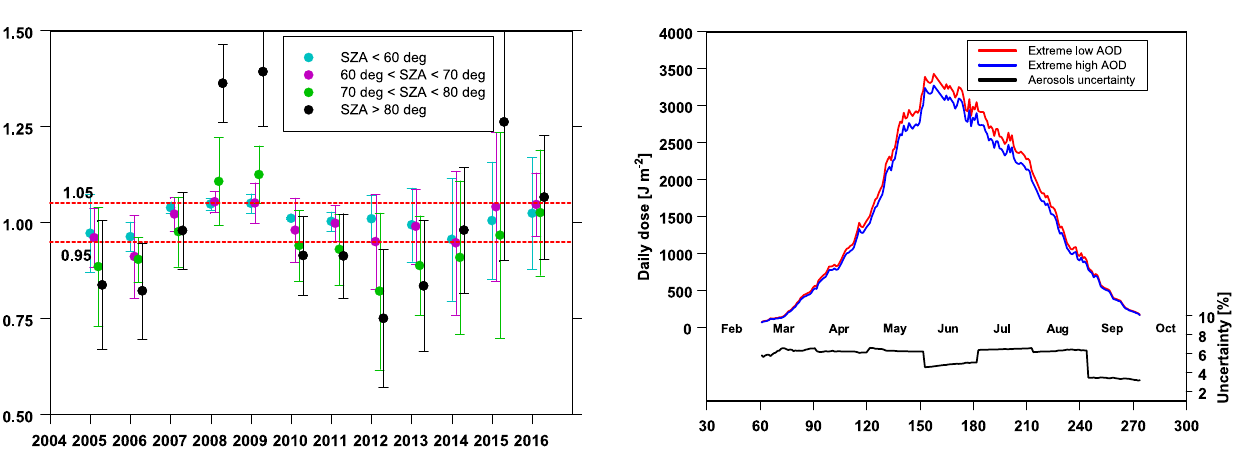
Figure 2. The calibration constants for the Kipp & Zonen UVS-AE- T instrument in the period 2005–2016 derived from a comparison of the modeled clear-sky doses with the observed ones in cloudless conditions for four solar zenith angle (SZA) ranges.